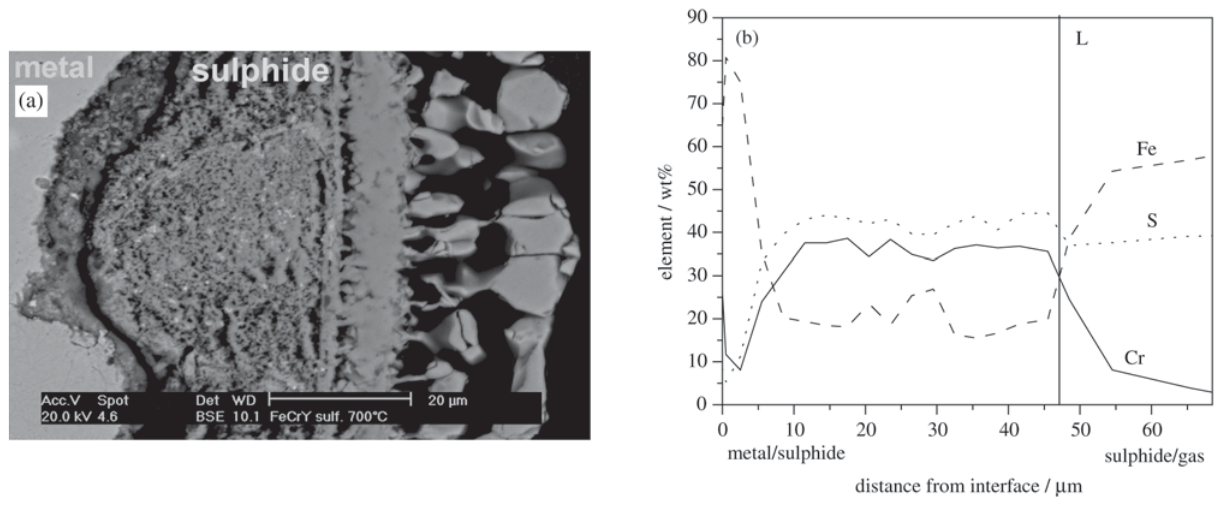
Figure 4. a) cross-section of FeCrY alloy sulphidised at 700 °C; b) composition profile through